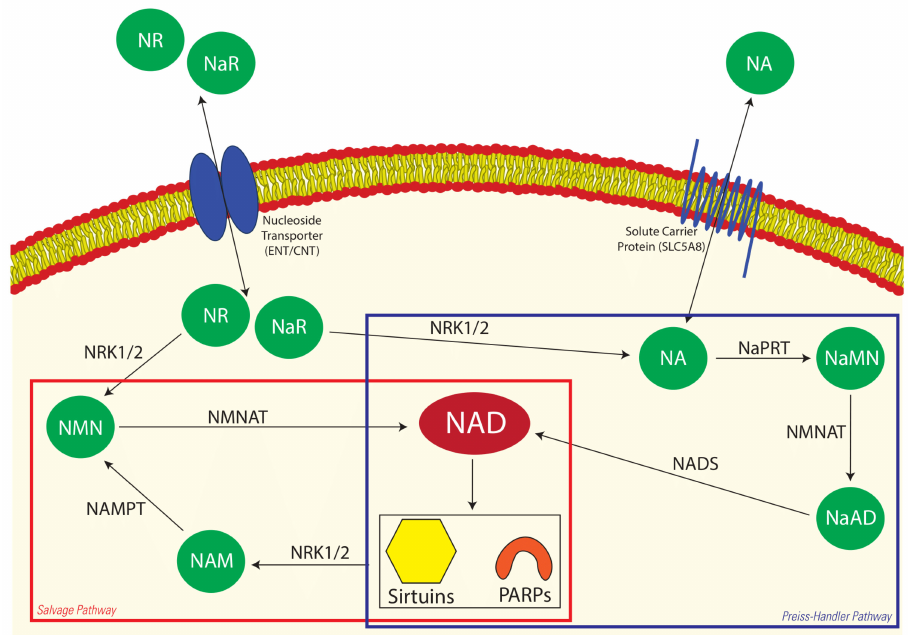
Figure 1. Two NAD + biosynthetic pathways in the cell. NA enters the cell via facilitated diffu- sion through solute carrier proteins where it is converted to NaMN via NaPRT. NMNAT then converts NaMN to NaAD before it is converted to NAD + via NADS. Sirtuin proteins and PARPs consume NAD + , which releases NAM. NAMPT then converts NAM to NMN, which is then re- cycled back into NAD + by NMNAT. NaR and NR enter the cell through nucleoside transporter proteins where they feed into the Preiss–Handler and salvage pathways, respectively. The two NAD + pathways are highlighted in their respective boxes. The metabolites examined in this study are represented in green, and NAD + is the end product of each pathway, represented in red. NA—nicotinic acid, NaMN—nicotinic acid mononucleotide, NaAD—nicotinic acid adenine dinucleotide, NAD—nicotinamide adenine dinucleotide, NAM—nicotinamide,